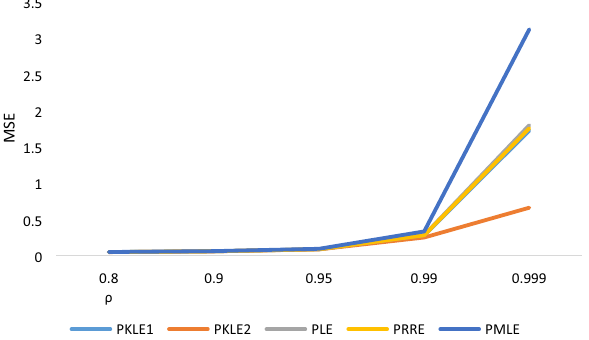
Figure 4. Intercept = 1; n = 200; p = 4.